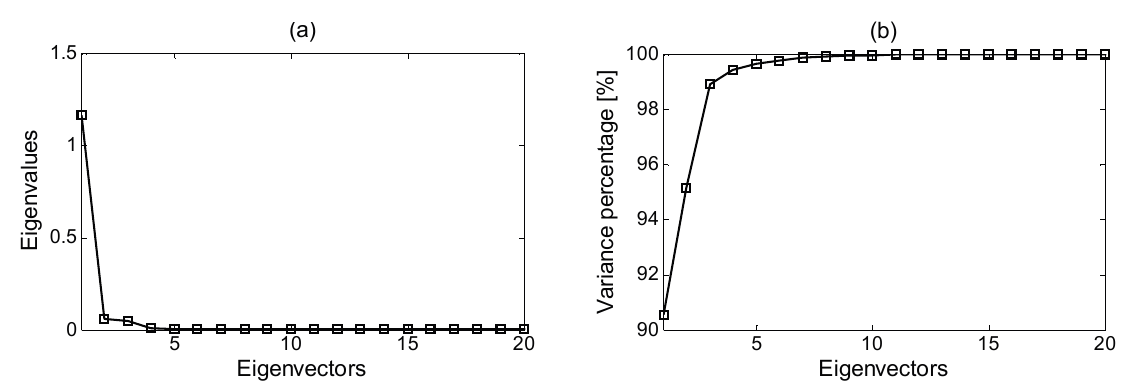
Figure 10. Representation of ( a ) the first 20 eigenvectors, and ( b ) their percentage of variance.